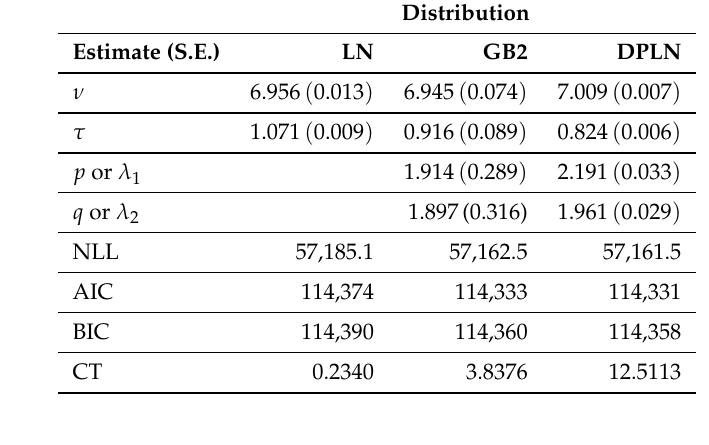
Table 2. Model fitting results of the LN, GB2 and DPLN distributions regarding automobile insurance claims.